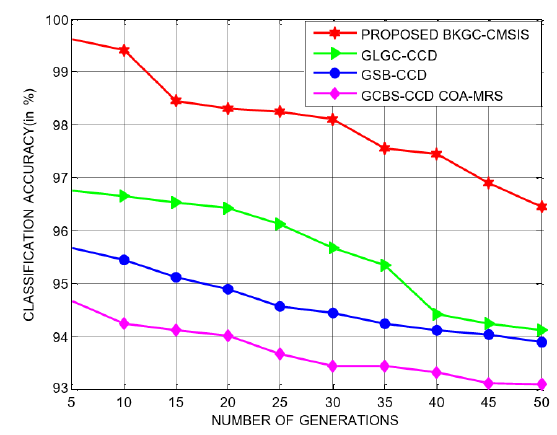
Figure 3. Classification accuracy of the proposed BKGC-CMSIS scheme